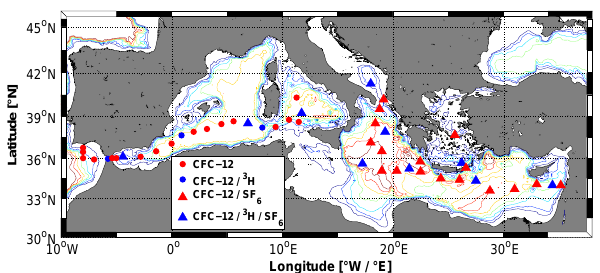
Figure 1. Transient tracer sample stations of the M84/3 cruise from Istanbul to Vigo. Triangles indicate stations including SF 6 mea- surements and a blue color coding indicates tritium measurements. CFC-12 was measured at all stations on this map. The depth contours are 500:500:3500.